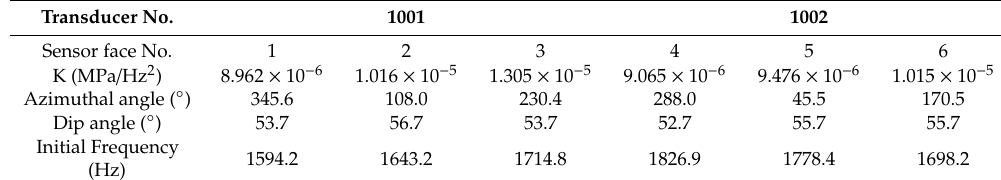
Figure 13. Relationship between elastic modulus and loading factor.